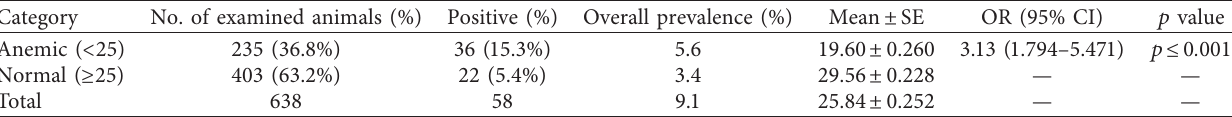
Table 5: Univariable logistic regression analysis of anemic and nonanemic cattle.